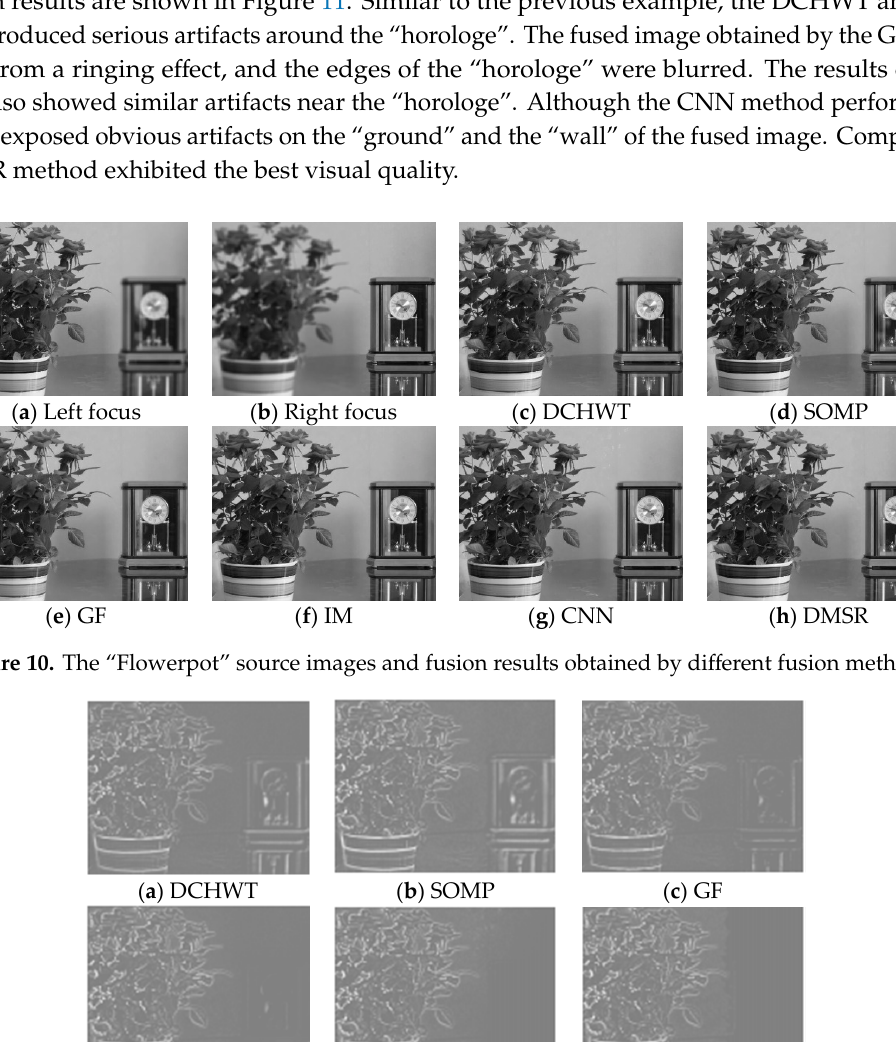
Figure 11. Normalized difference images between each of the fused images and Figure 10b.